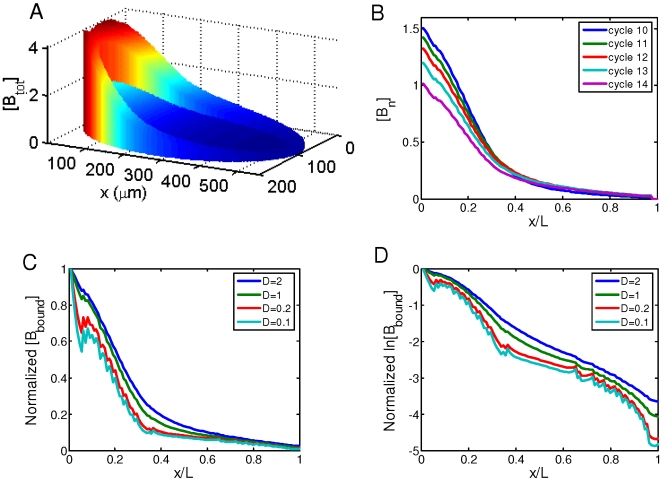
Simulating the effects of the dynamics of bcd mRNA distributions.A. A simulated embryo at nuclear cycle 14 showing the [Btot] (arbitrary units). Although the profiles of the redistributed bcd mRNA within the cortical layer have been reported [31], their precise functions have not been well characterized. Here we approximate the redistributed bcd mRNA profile during nuclear cycles 10–14 using two phases of decreases along the projected A–P axis (from the anterior, the relative bcd mRNA concentration within the cortical layer decreases linearly to 0.15 at x/L = 0.3 and further drops linearly to 0 at x/L = 1). Parameter values for simulations described in this figure are: D = 2 µm2s−1, ω = 0.0005 s−1, KA = 2×105 M−1, and [DNAsites]10 = 3×10−7 M. B. Same simulation as in A, showing the stability of [Bn] (arbitrary units) within the cortical layer during nuclear cycles 10–14. C. Same as in B, except with a progressive reduction (at selected intervals shown for clarity) of diffusion constant D (2, 1, 0.2, and 0.1 µm2s−1) to determine the role of Bcd protein diffusion in gradient formation. [Bbound] within the cortical layer is normalized to 1 at x/L = 0 to facilitate the comparison between results obtained under different simulation conditions. D. Same as in C, except the normalized [Bbound] is on ln scale. Linearity of ln[Bbound] indicates an exponential Bcd protein gradient. See Fig. S4A for a plot of Adjusted R
2 values as a function of D.